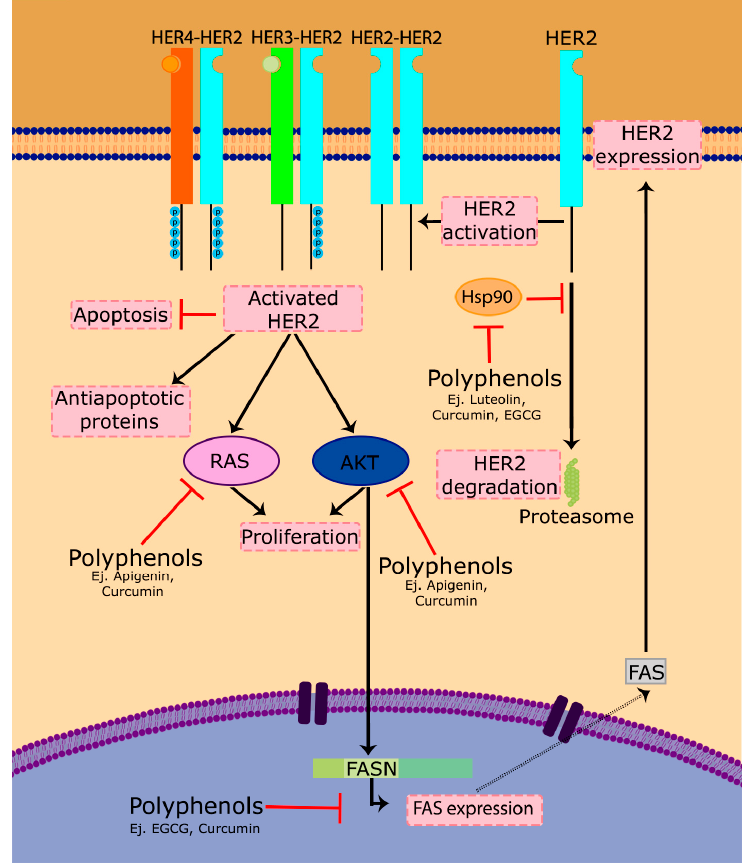
Figure 3. Polyphenols modulate the HER2 pathway. The HER2 membrane receptor, when activated, dimerizes with other HER2 (homodimerization) or other HER family receptor (heterodimerization) and transduces proliferation signals to downstream pathways such as the Ras/Raf or PI3K/Akt routes. This activation also inhibits apoptotic signals and promote antiapoptotic mechanisms. In addition, HER2 expression can be modulated by FASN, and some polyphenols are able to modify this action by actuating on FASN activity and/or expression. Finally, Hsp90 chaperone is required for HER2 to be functional, and some polyphenols modify this interaction leading to HER2 degradation by proteasome.